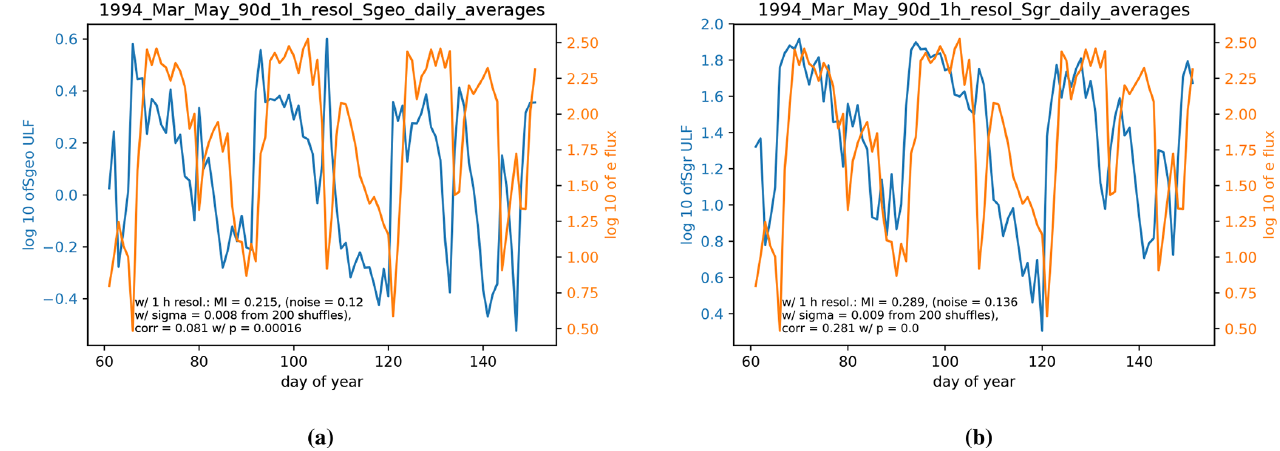
Figure 2. (a) The 24h average of relativistic electron flux index F e 1 . 2 and geosynchronous ULF index S geo for the 1994 event from the Rostoker et al. (1998) study. (b) Same as for panel (a) but with ground ULF index S gr for the 1994 event. We note that visually the ground index S gr follows the relativistic electron flux index more closely for the duration of the event.